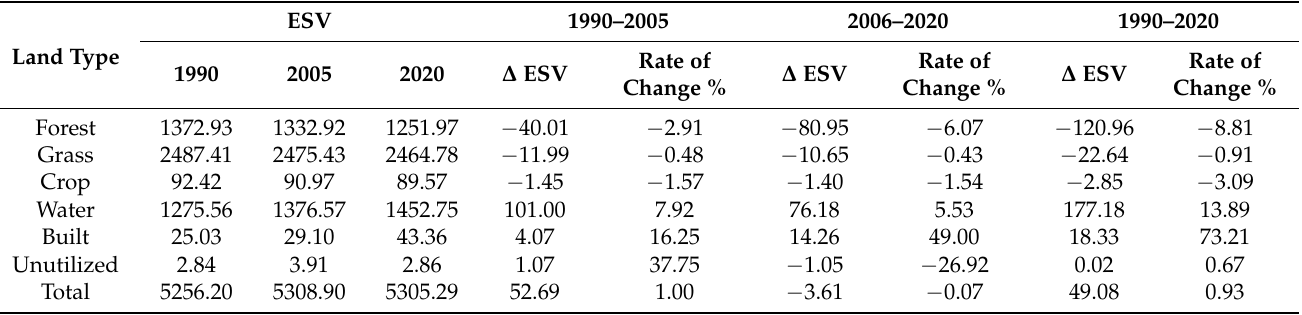
Table 4. Changes of total value of ecosystem services in Wuhan metropolitan